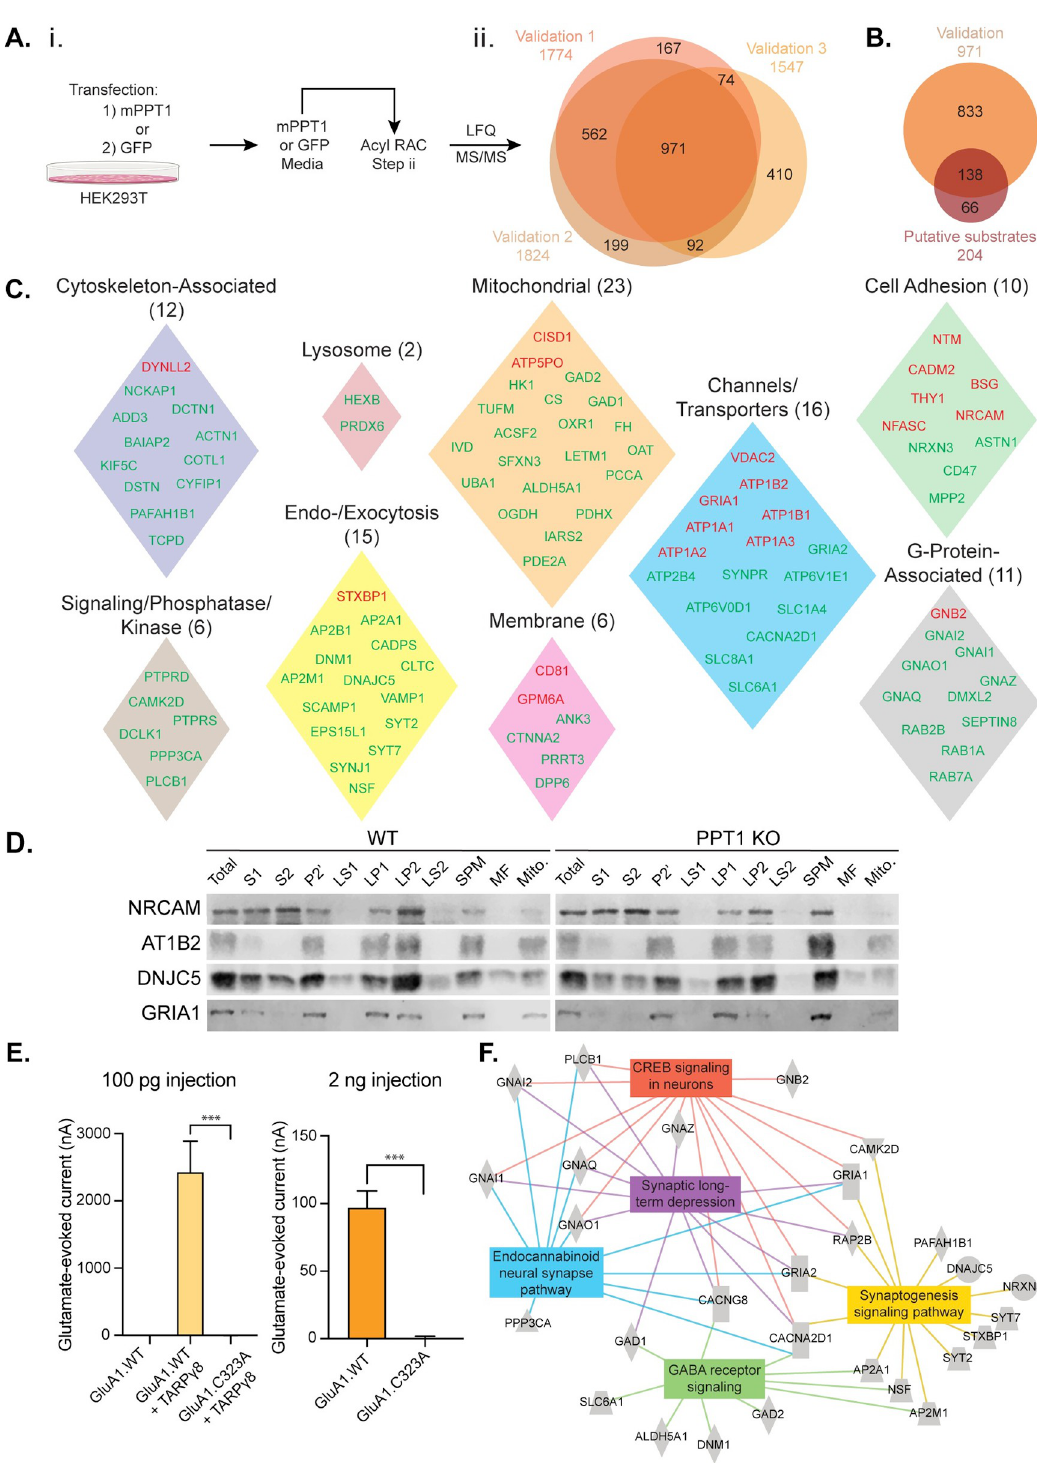
Fig 3. Direct depalmitoylation with PPT1 validates putative synaptic substrates. (A) (i) Schematic of PPT1-mediated depalmitoylation assay, in which solubilized synaptosomes are treated with recombinant mPPT1 or GFP generated from HEK293T cells during Acyl RAC ( Fig 1Bii ). (ii) Venn diagram of PPT1-mediated depalmitoylation assay ( n = 3 biological replicates, n = 3 technical replicates) shows 975 proteins common to replicates. (B) Comparison of PPT1-mediated depalmitoylation proteins to putative substrates results in 138 validated PPT1 substrates. (C) The 138 combined high- (red) and medium- (green) confidence